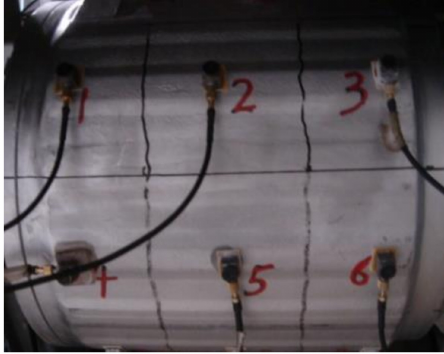
Figure 12. Arrangement of sensors at Points 1–6 for measuring the motor-acceleration excitations.